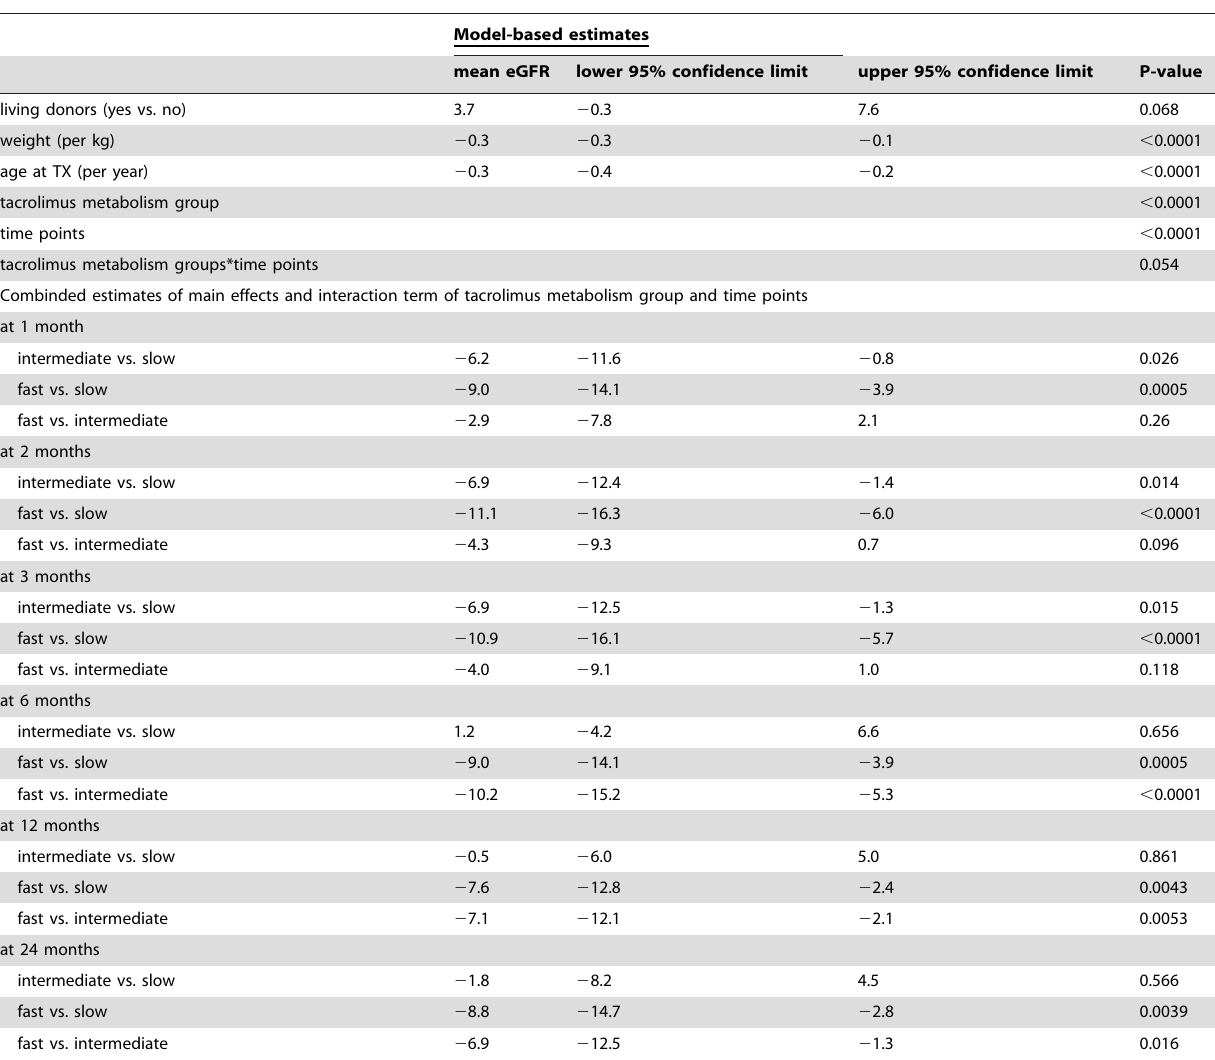
Table 3. Renal function (linear mixed